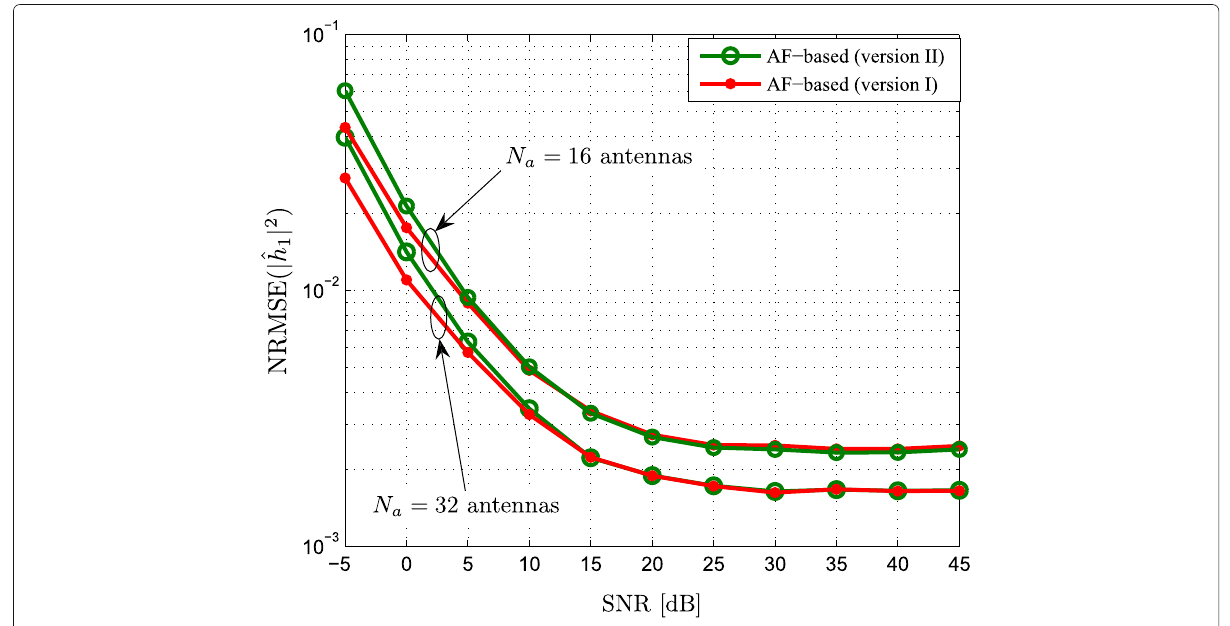
Fig. 9 NRMSE of the channel power estimators ( versionsI and II ) with N = 1000, θ 1 = 18°, θ 2 = 36°, K = 2, N a = 16, 32, and σ 2 = 2